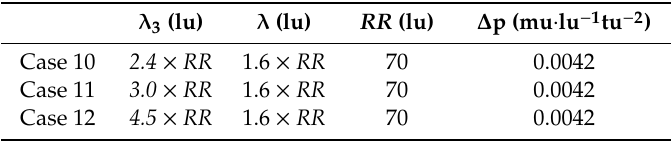
Figure 16. Computational layout for double bubbles with horizontal arrangement. ( λ 3 —the distance between the center of two bubbles). Table 4. Used parameters in Cases